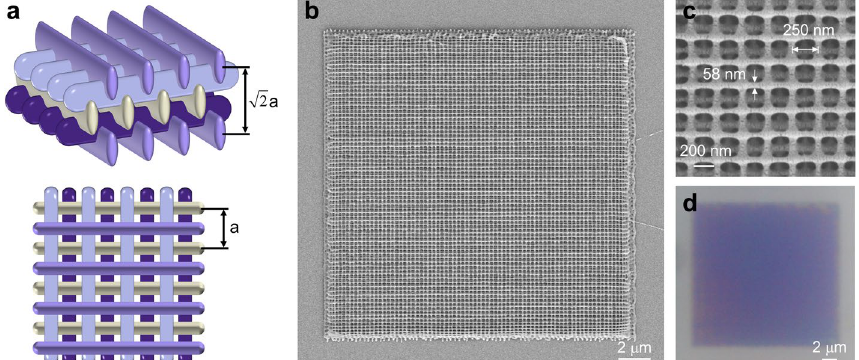
Fig. 6 3D subwavelength structured photonic crystals fabricated by SC-PPI lithography. a Schematic of 3D woodpile structure with lattice constant a and axial period √ 2a. The SEM image ( b ) and the magnified SEM image ( c ) of the woodpile structure fabricated by SC-PPI lithography with a feature size of 58 nm, and a lattice constant of a 250 nm, under a writing speed of 1 mm s − 1 . For comparison, the smallest lattice constant of = 3D woodpiles printed using PPI lithography was reported to be 275 nm with a writing speed of 0.1 mm s − 1 (ref. [22]). d Reflection-mode optical micrographs of the 3D woodpile